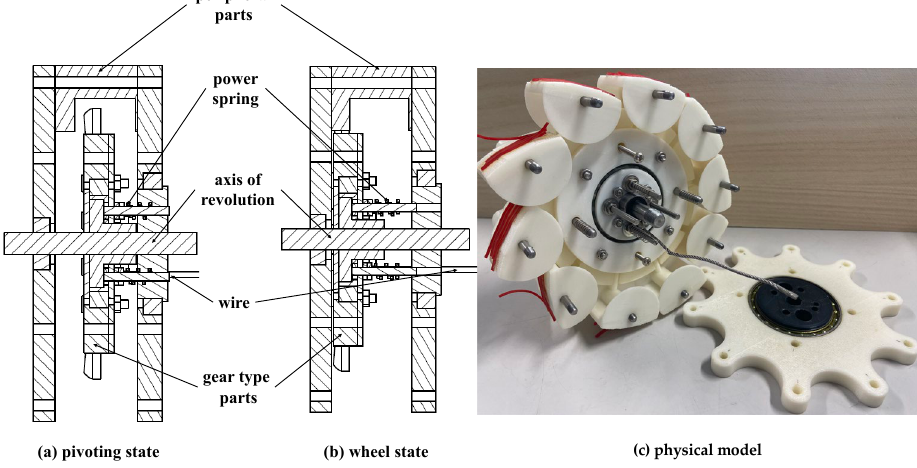
Figure 1. Pivot fixing and releasing mechanism (( a , b ) Sectional view; ( c ) Demo).